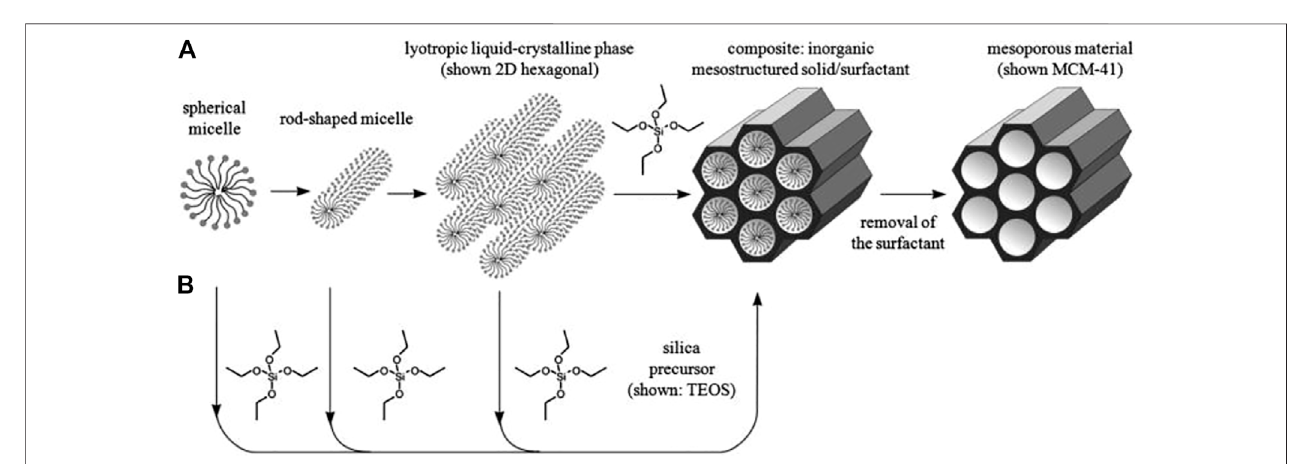
FIGURE 2 | Possible pathways for the synthesis of mesoporous materials (A) Liquid crystal templating and (B) self-assembly.